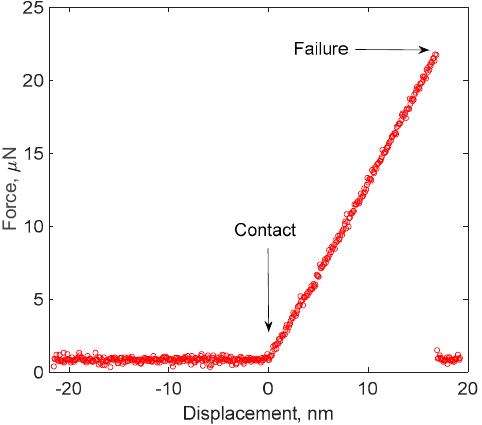
Figure 5. Typical force-displacement response of micro-cantilever beam ( L = 4 µm).